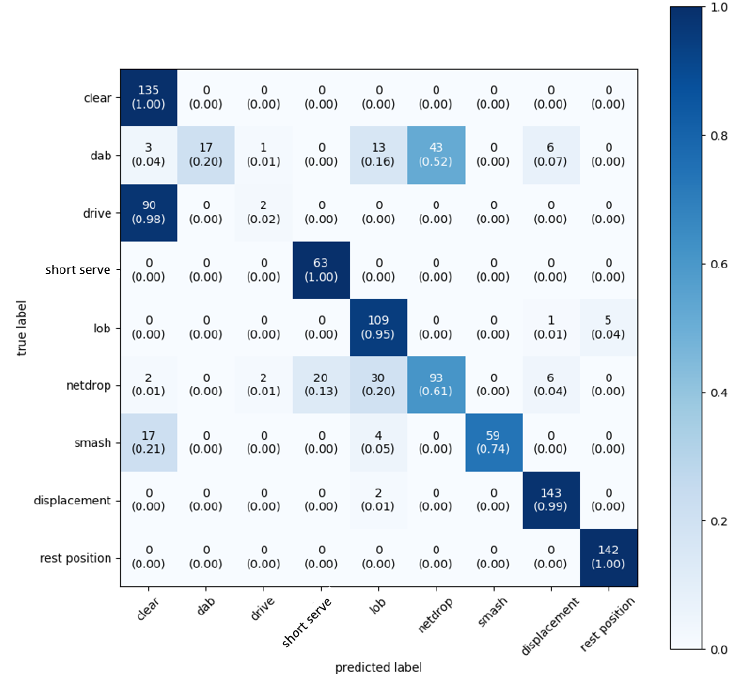
Figure 4. Confusion matrix: only accelerometer data and a sampling frequency of 12.5